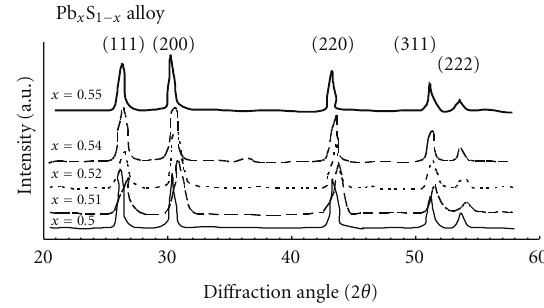
Figure 1: X-ray di ff raction pattern for Pb x S 1 − x alloy at various value of x content.